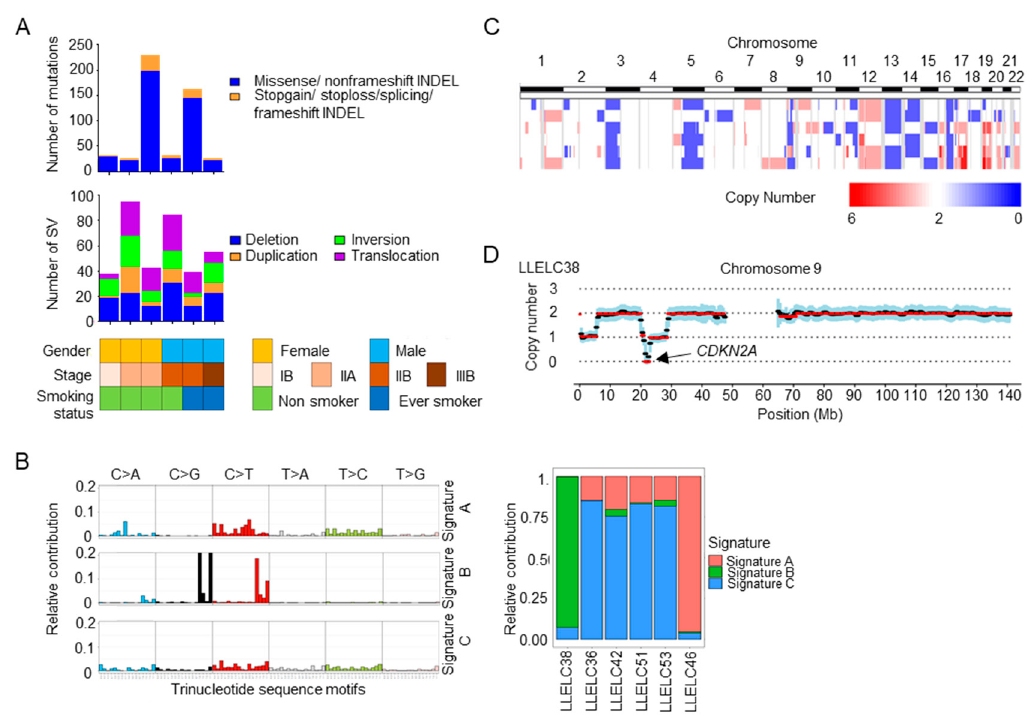
Figure 2. Frequencies of non-silent somatic mutations and structure variations, mutational signatures and copy number alterations of pulmonary lymphoepithelioma-like carcinoma identified by whole genomic sequencing. ( A ) Frequencies of non-silent somatic mutations and structural variations in pulmonary LELC. ( B ) (Left) Three mutational signatures A–C were identified. Mutational signatures were displayed according to 96 substitutions classification defined by the substitution class and sequence context immediately before and after the mutated base. (Right) The relative contribution of signatures A–C in six pulmonary LELC tumors. Each bar represents a single pulmonary LELC case. ( C ) Global chromosomal gains (shown in red) and losses (shown in blue) across six pulmonary LELCs. ( D ) Homozygous deletion of CDKN2A was identified in one tumor (LLELC38). LELC, lymphoepithelioma-like carcinoma. SV, structural variation.